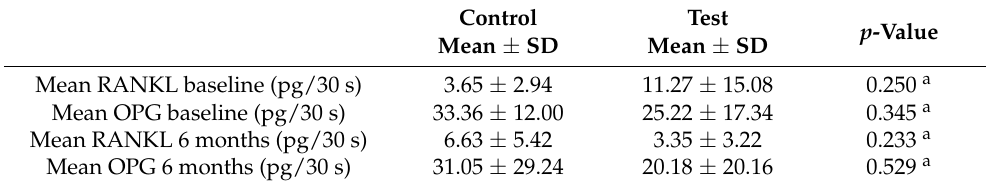
Table 4. Baseline and six-month values of OPG and sRANKL in the two groups.